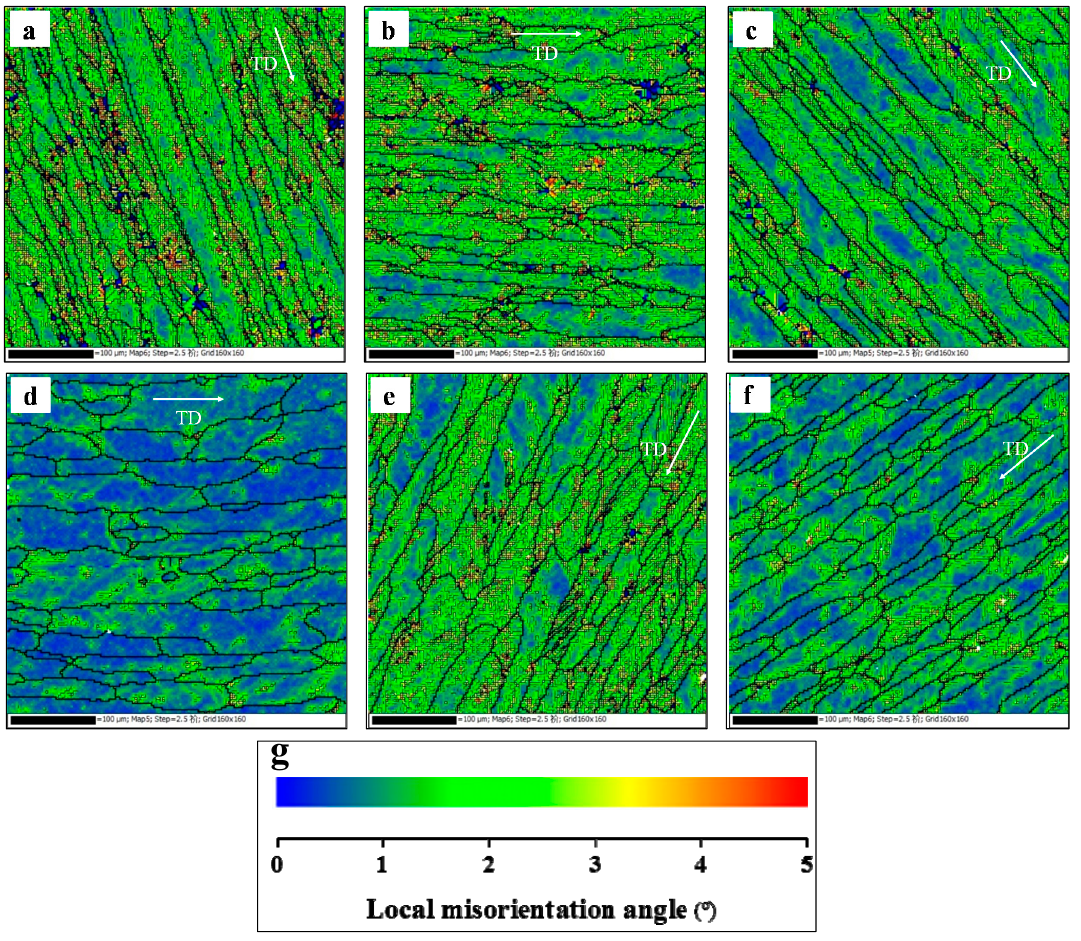
Figure 6. Kernel average misorientation (KAM) maps of the stretched alloy at ( a ) T = 100 °C, ε = 0.0003 s − 1 ; ( b ) T = 150 °C, ε = 0.0003 s − 1 ; ( c ) T = 200 °C, ε = 0.0003 s − 1 ; ( d ) T = 250 °C, ε = 0.0003 s − 1 ; ( e ) T = 200 °C, ε = 0.003 s − 1 ; and ( f ) T = 200 °C, ε = 0.00003 s − 1 ; ( g ) The scale label.